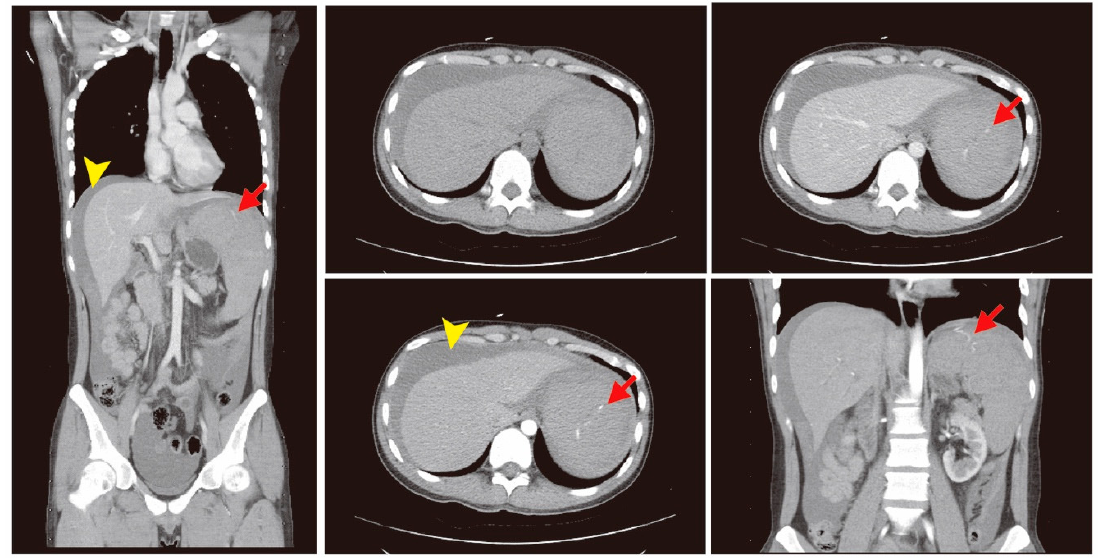
Figure 1. The abdominal contrast enhanced computed tomography (CT) showed splenomegaly and a splenic rupture (red arrow) with hemoperitoneum (yellow arrow head).